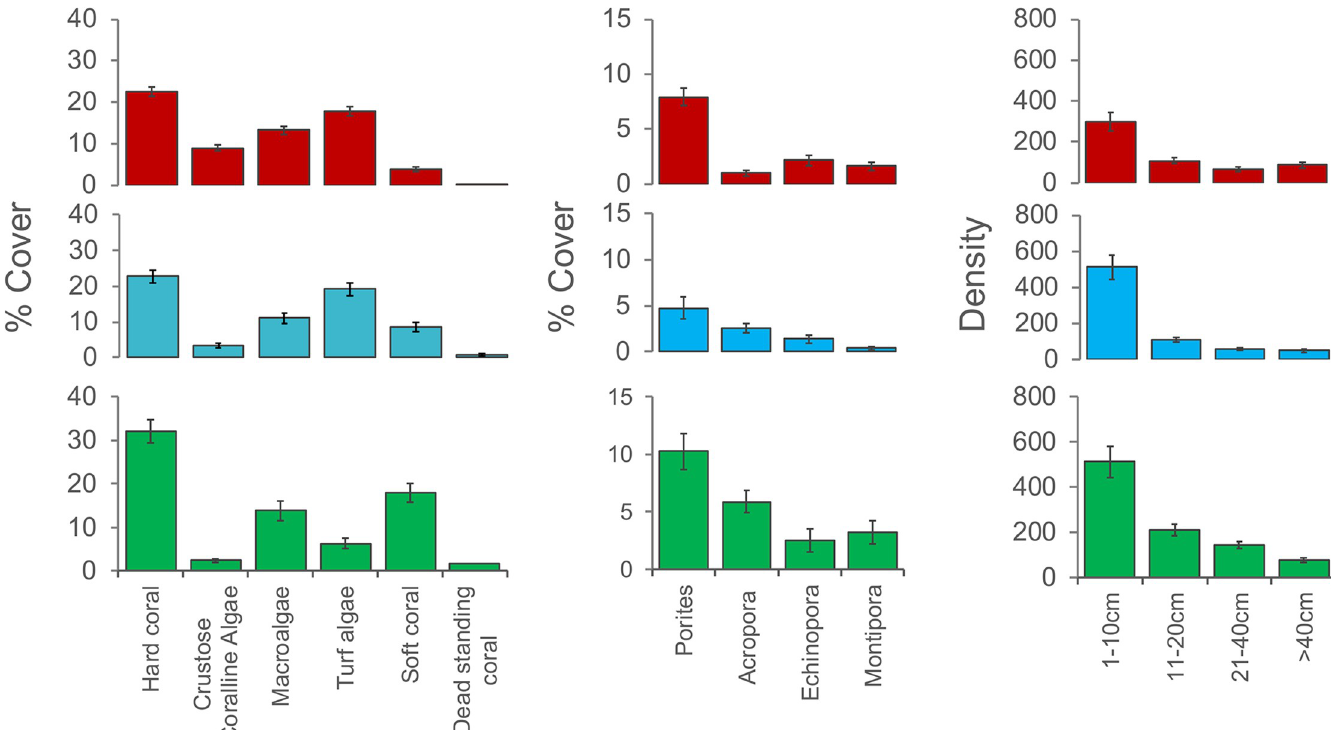
Fig 3. Summary of benthic community variables by geographic zone. Mean percentage cover of five major benthic cover categories, four coral genera and density (number of colonies per 100m 2 ) of four coral size classes for north (upper, red), central (middle, blue) and south (lower, green) geographic zones. Error bars indicate standard